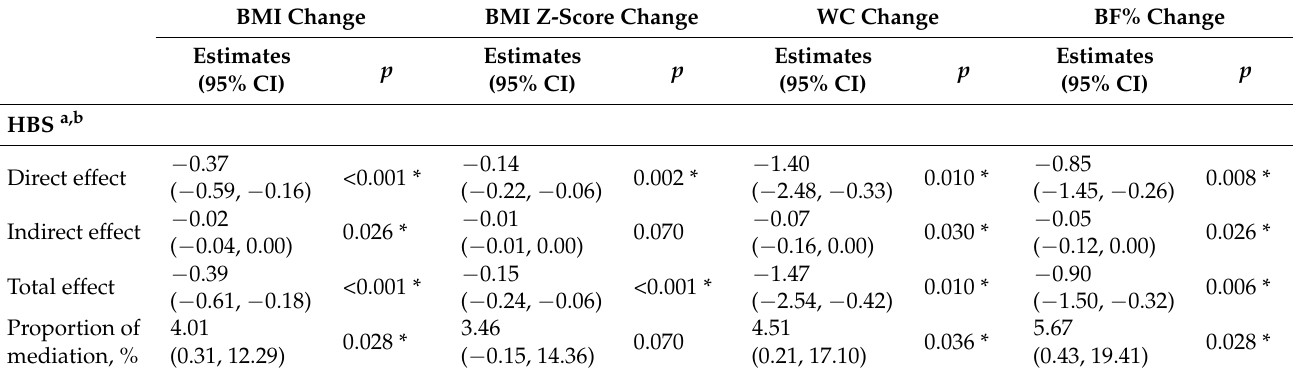
Table 4. Mediating role of dietary quality in the intervention effects on changes in BMI, BMI z-score, WC, and body fat percentage a